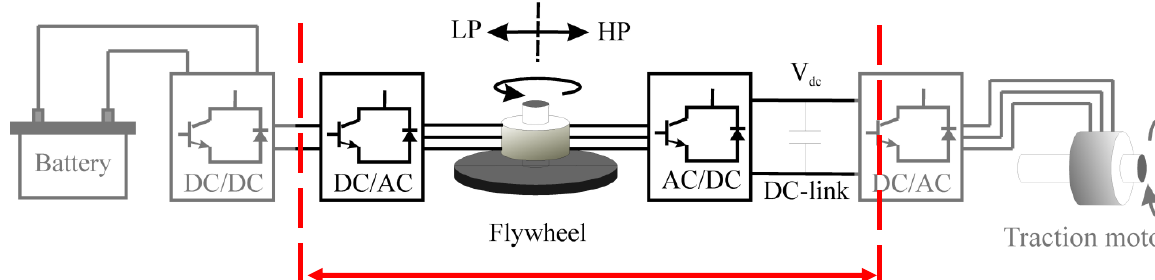
Figure 1. All-electric driveline based on a double wound flywheel machine. Energy is transferred from the battery to the flywheel at low power. The flywheel delivers/receives high transient power to/from the traction motor. The dotted lines indicate the part of the system (the TPLS) under consideration in this